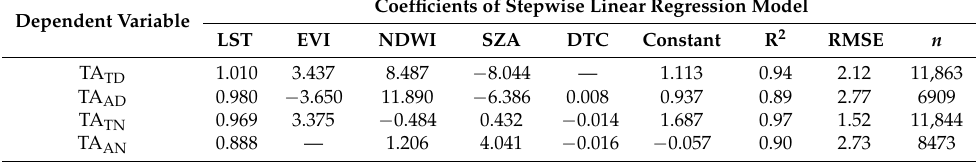
Table 2. Coefficients of the stepwise linear regression models for estimating air temperatures based on training dataset at the four overpass times. A value present indicates that the variable is significant with p < 0.01, and a dash indicates that the independent variable is not significant for that temperature variable at the aforesaid confidence level.